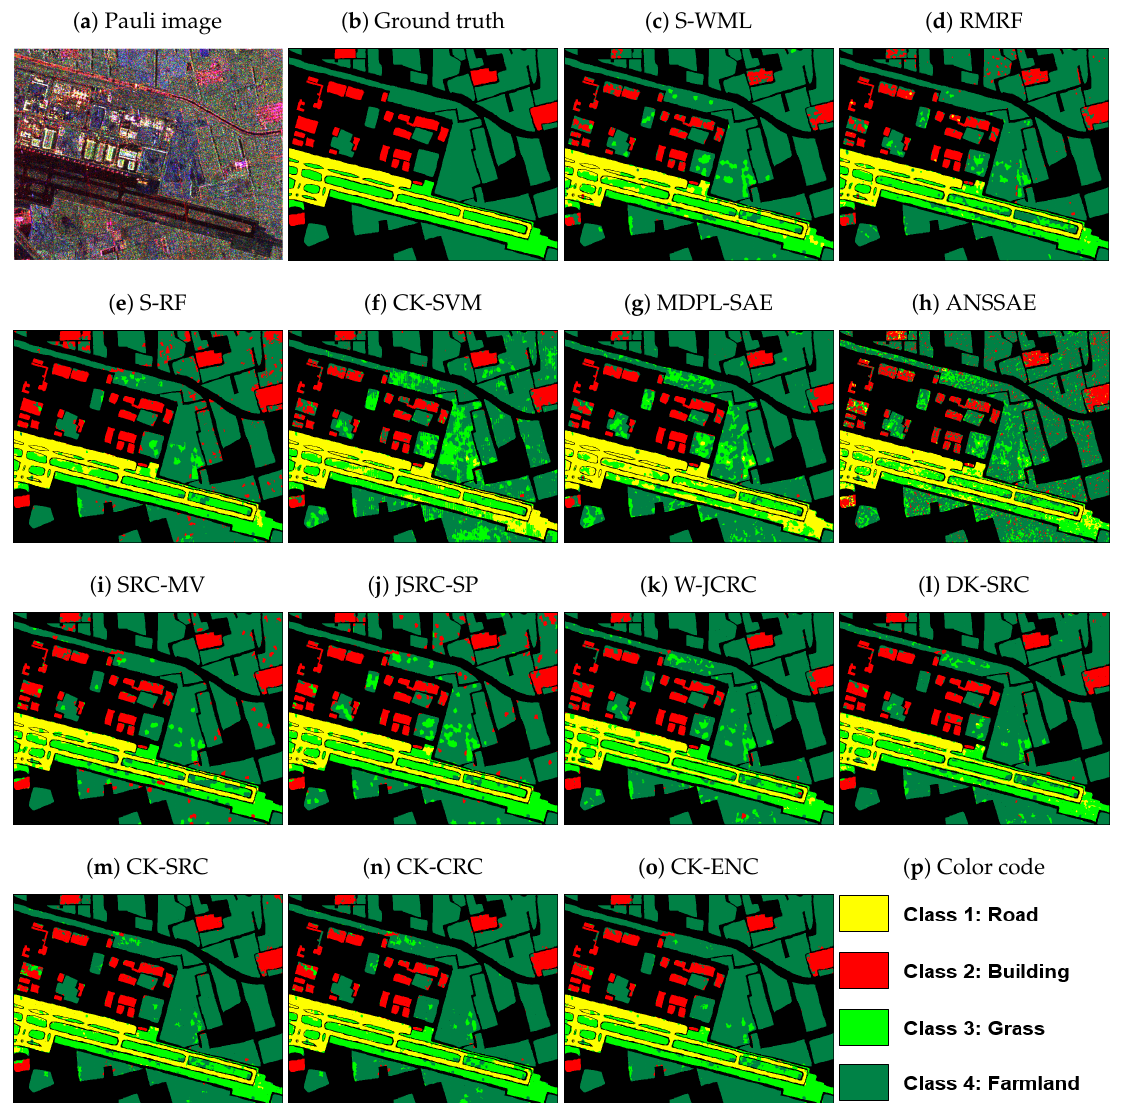
Figure 9. Classification results of the Yihechang dataset with different